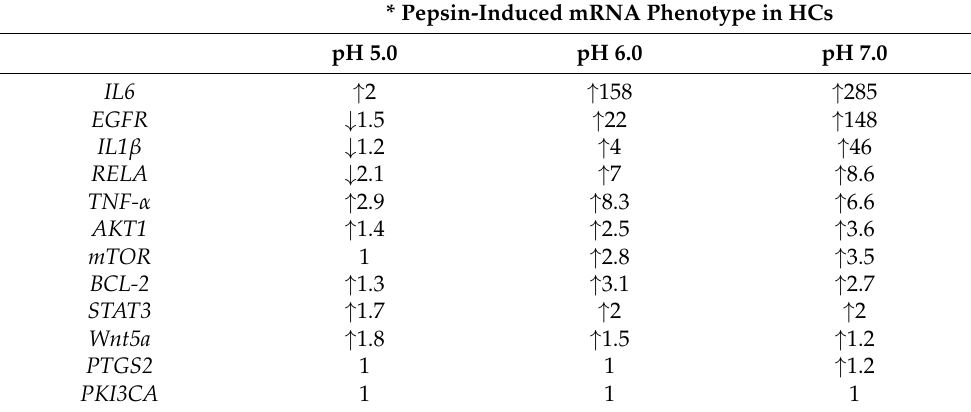
Table 1. Pepsin-induced mRNA oncogenic phenotype in human hypopharyngeal primary cells